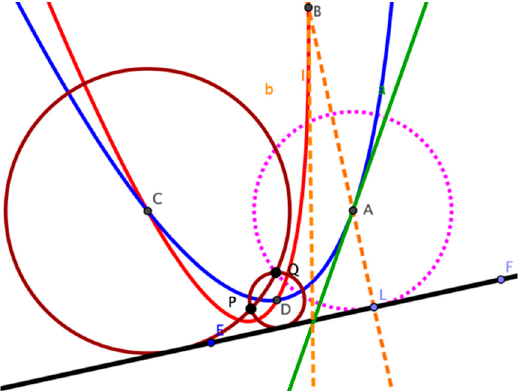
Figure 6. The loci of points A & B when point L is moved along line EF are parabolas that intersect at the centers of tangent circles to line EF and pass through points P & Q (https://www.geogebra.org/ m/vycaymhz, accessed on 18 January